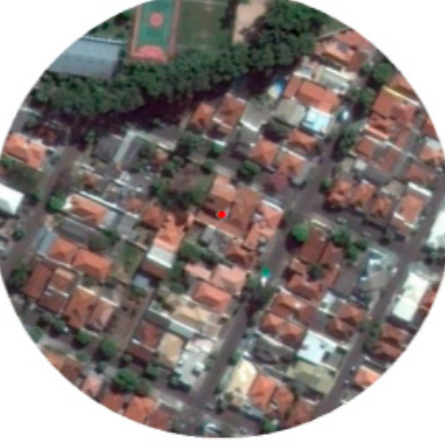
Figure 3. Characteristics of the urban environment of Presidente Prudente (red point).